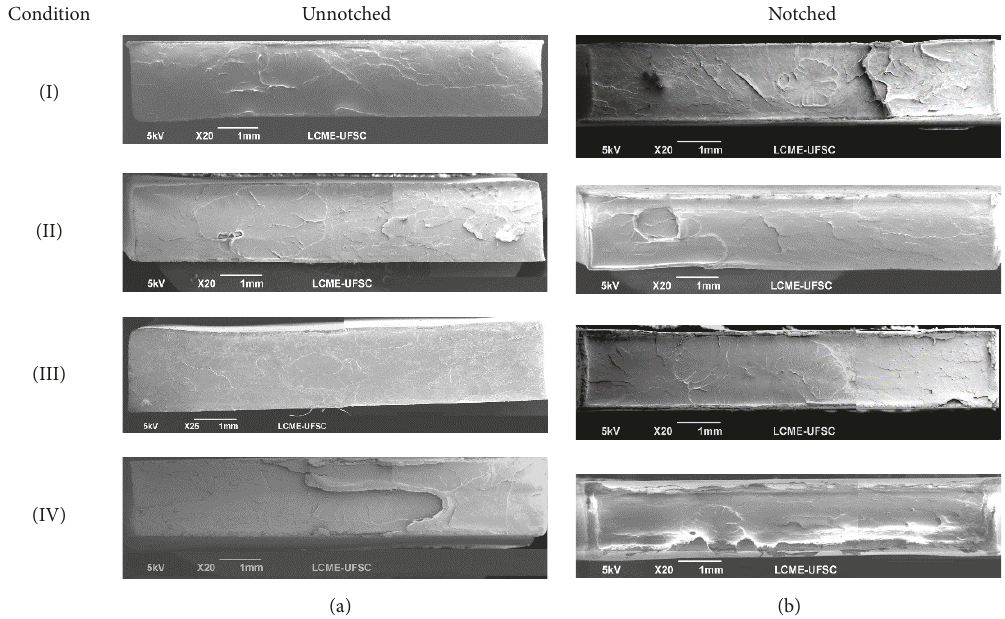
Figure 4: SEM of fractured surface unnotched (a) and notched (b) PLGA specimens molded under different processing conditions.